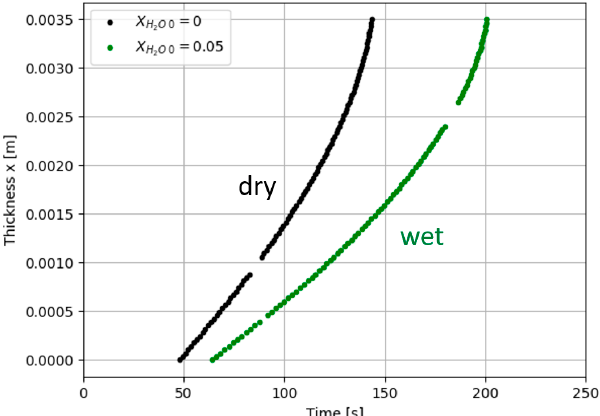
Figure 13. Kinetics of the combustion advancing front for a degradation rate of 50%. Comparison of numerical simulation prediction as a function of combustion time between pure thermal and hygro-thermal models for an E-glass / polyester composite laminate exposed to a heat flux of 50 kW / m 2 .